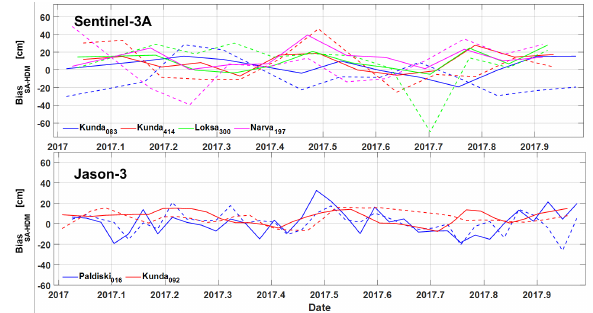
Figure 8: The Sentinel-3A (top) and Jason-3 (bottom) associated bias SA − HDM using standard (dash lines) and ALES+ (lines) retrack- ers at the used TG